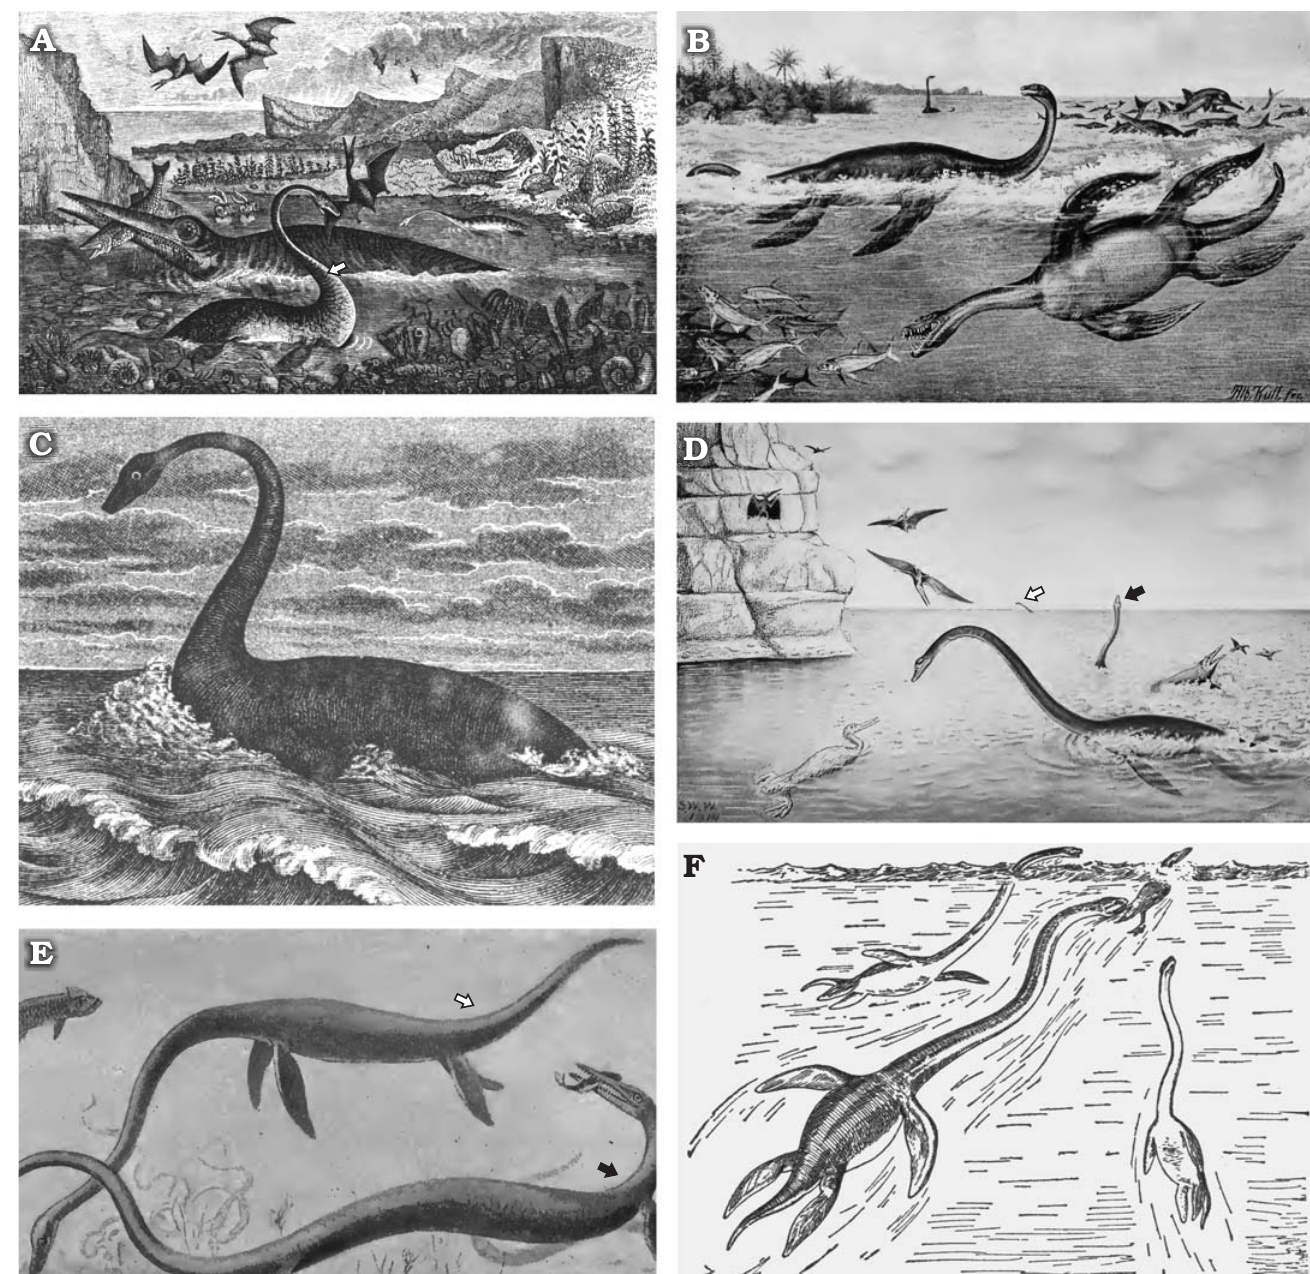
Fig. 3. Previous hypotheses of neck function of plesiosaurs. A . An unnamed plesiosaur (possibly Plesiosaurus dolichodeirus ) swimming at the sea surface and preying on a pterosaur (note this duplicates the concept illustrated in Fig. 2B). B . Plesiosaurus guilelmi imperatoris (now genus Seeleyosaurus ) with neck curved dorsally and swimming at the surface, and Thaumatosaurus victor (now genus Meyerasaurus ) with neck held straight and chasing fish un- derwater. C . Plesiosaurus dolichodeirus swimming at the water surface, possibly scanning for submerged prey. D . Elasmosaurus platyurus uses its neck to hunt fish close to the ocean surface. Note a similar pose in the individual in the far distance (white arrow), but the almost vertical position of the neck in the individual in the centre right (black arrow). E . Elasmosaurus (white arrow) swimming beneath the surface and apparently feeding on benthic prey, with Clidastes (a mosasaur) catching a fish (black arrow). F . Three individuals of Elasmosaurus chasing down the flightless marine bird Hesperornis . Images from: A, Richardson (1851: frontispiece, “designed, drawn and engraved by Mr Nibbs”); B, Winkler (1873: “Le plésiosaure”); C, Hutchinson (1897: pl. 13, detail); D, E, Williston (1914: fig. 31 and 33, respectively); F, from Osborn (1918: fig. 86, upper part, drawn by W.K. Gregory from data by Williston